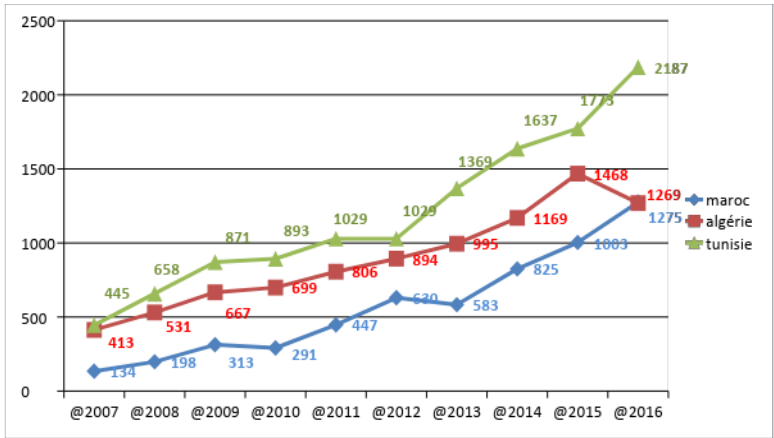
Fig. 1. Growth of Moroccan production in "Computer Science" from 2007 to 2016: in comparison with Tunisia and